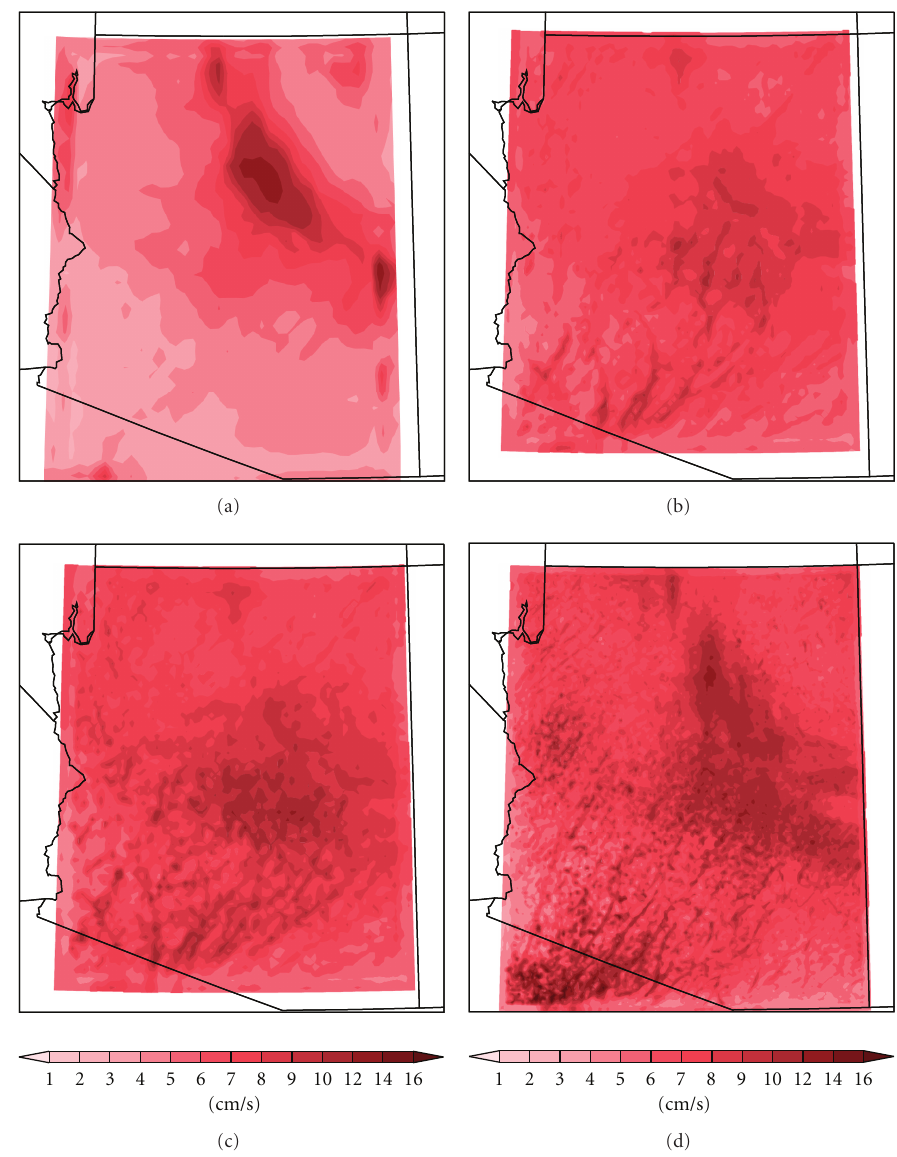
Figure 11: The standard deviation of vertical velocity at 625 hPa level for (a) the 12km runs, (b) the 6km runs with cumulus parameterization turned on, (c) the 6km runs with cumulus parameterization turned o ff , and (d) the 3km runs. The color scale in cm/s is shown at